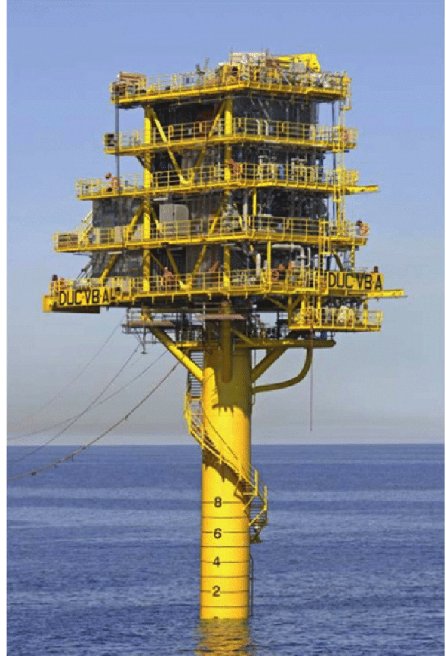
Figure 2: A photo of Valdemar tripod jacket